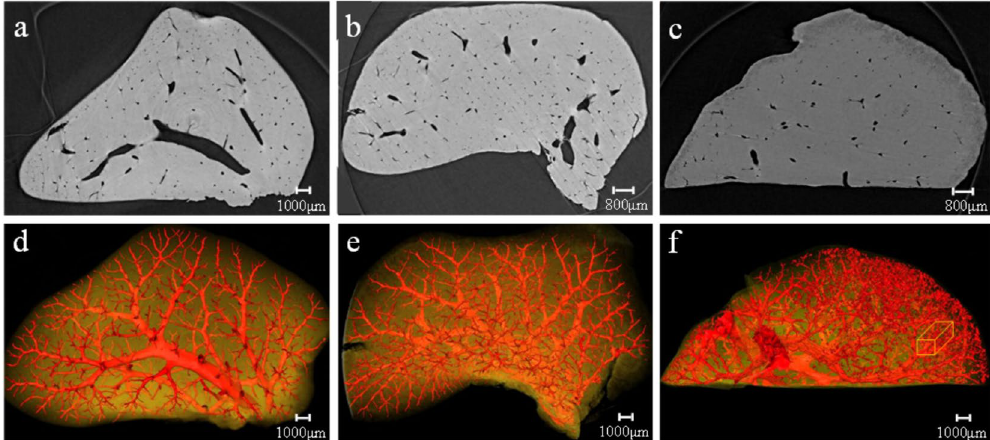
Figure 1. Slices and corresponding 3D microvasculature rendering images from different groups. A hepatic vascular tree is presented with regular shapes in the control group ( a , d ). Tortuous and abnormal microvascular structure caused by fibrosis tissues occured at week 2 post-BDL ( b , e ). The disordered microvascular structure and abnormal microvascular morphology become more apparent at week 6 post-BDL as the fibrosis stage increased ( c , f ). The ductular proliferation marked by a yellow cuboid is revealed in ( f